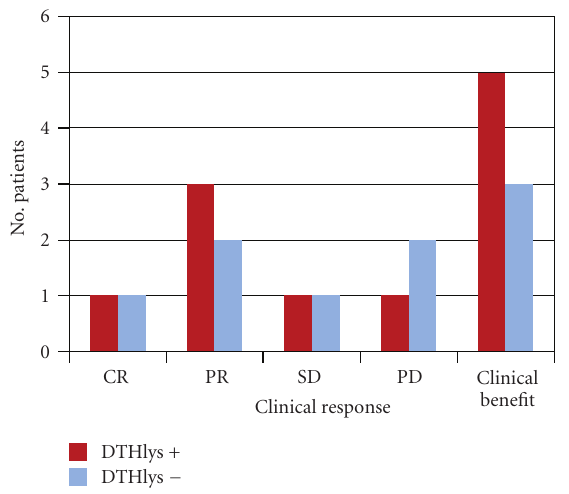
Figure 5: Subdivision of DTH positivity (+) and negativity ( − ) to lysate (DTH positivity to KLH is contained in the negative group) grouped on the basis of single response and clinical benefit